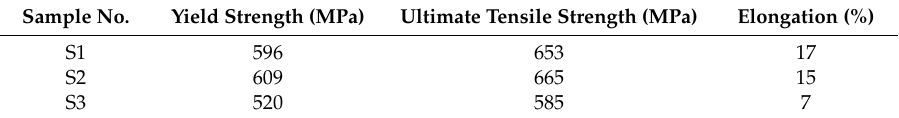
Table 3. Tensile test results of samples S1, S2 and S3 welded under different welding parameters.